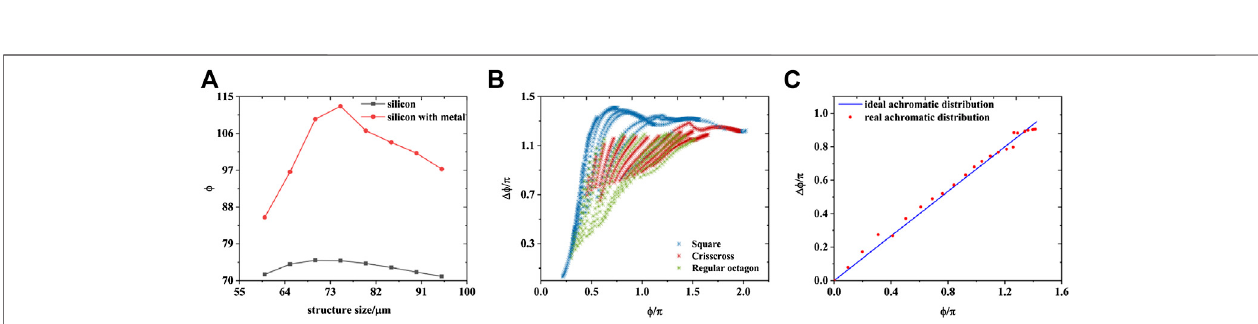
Frontiers in Physics |